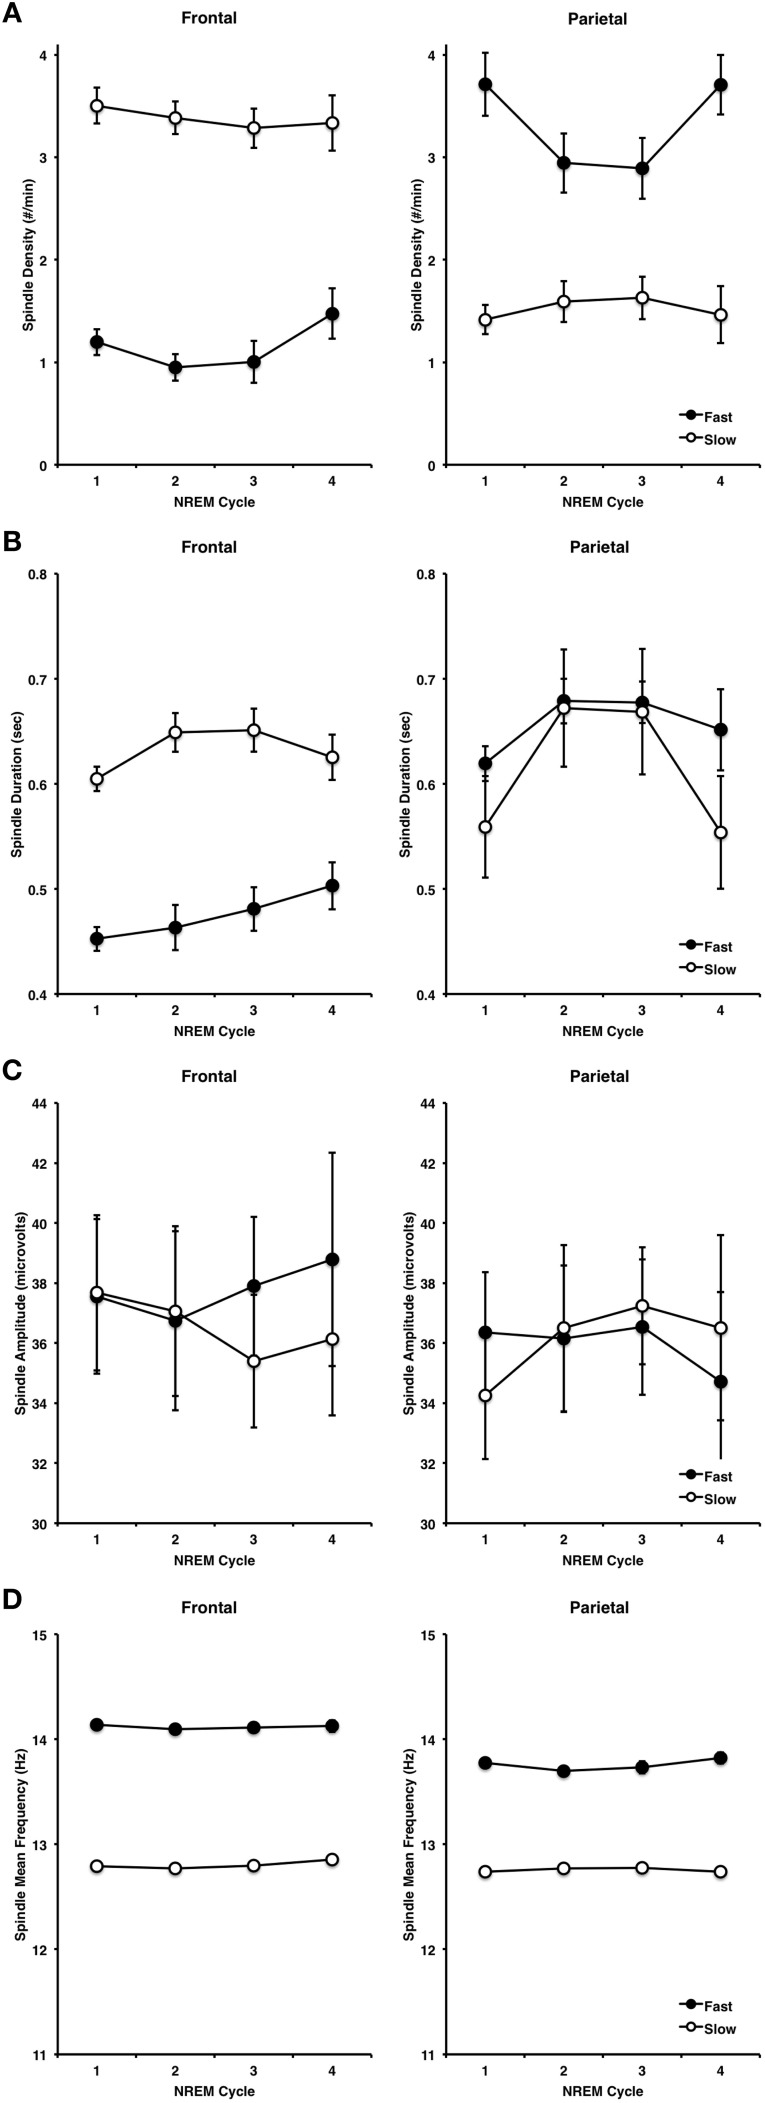
Spindle characteristics over the course of the first four NREM periods, at frontal and parietal regions for fast and slow spindle types, including density (A), duration (B), amplitude (C) and frequency (D).